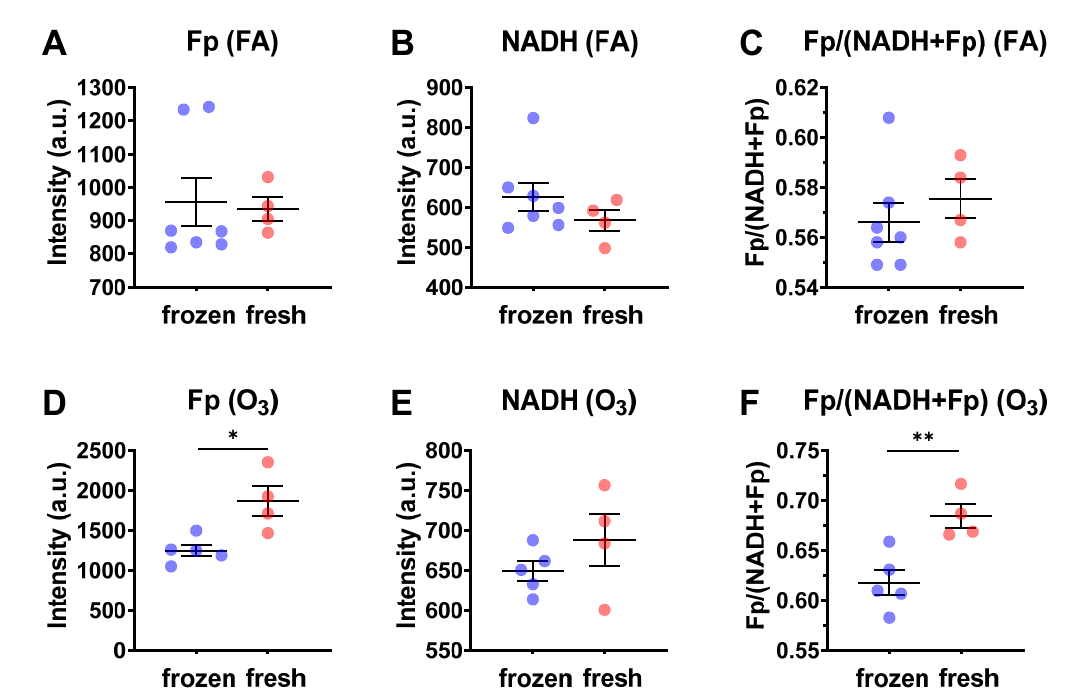
Figure 4. Comparisons of the redox indices between cryopreserved/frozen AM and fresh AM. Each dot represents an AM sample from one mouse. ( A – C ) Under FA exposure, there is no significant redox difference between cryopreserved/frozen AM and fresh AM; ( D – F ) under O 3 exposure, fresh AM were in a more oxidized redox state with significantly higher Fp values ( D ) and significantly higher redox ratios ( F ) (mean ± SD). * p < 0.05 and ** p < 0.01.